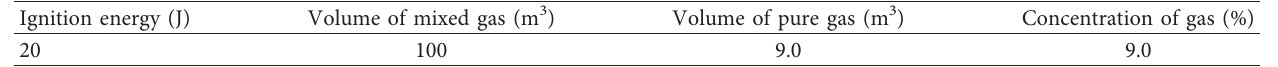
Figure 3: Arrangement diagrams of SD rat cages in the laneway. Table 1: Experimental conditions.